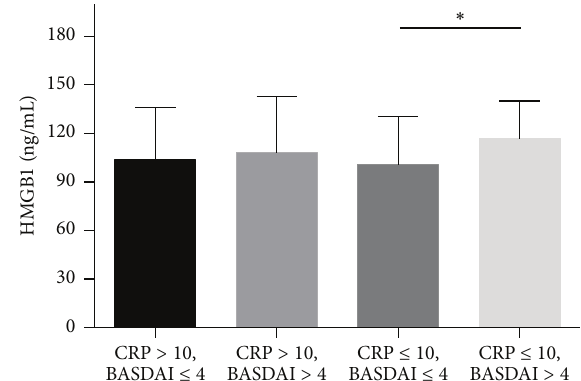
Figure 1: The comparison of serum HMGB1 in 4 groups of 147 AS patients, which were divided according to the value of CRP and BASDAI. Data include serum HMGB1 levels of 147 AS patients which were divided into 4 groups, defined as group 1 (CRP > 10 mg/dL + BASDAI ≤ 4, 𝑛 = 36 ), group 2 (CRP > 10 mg/dL + BASDAI > 4, 𝑛 = 40 ), group 3 (CRP ≤ 10mg/dL + BASDAI ≤ 4, 𝑛 = 51 ), and group 4 (CRP ≤ 10 mg/dL + BASDAI > 4, 𝑛 = 20 ). BASDAI: Bath AS Disease Activity Index; CRP: C-reactive protein. ∗ 𝑃 < 0.05 .